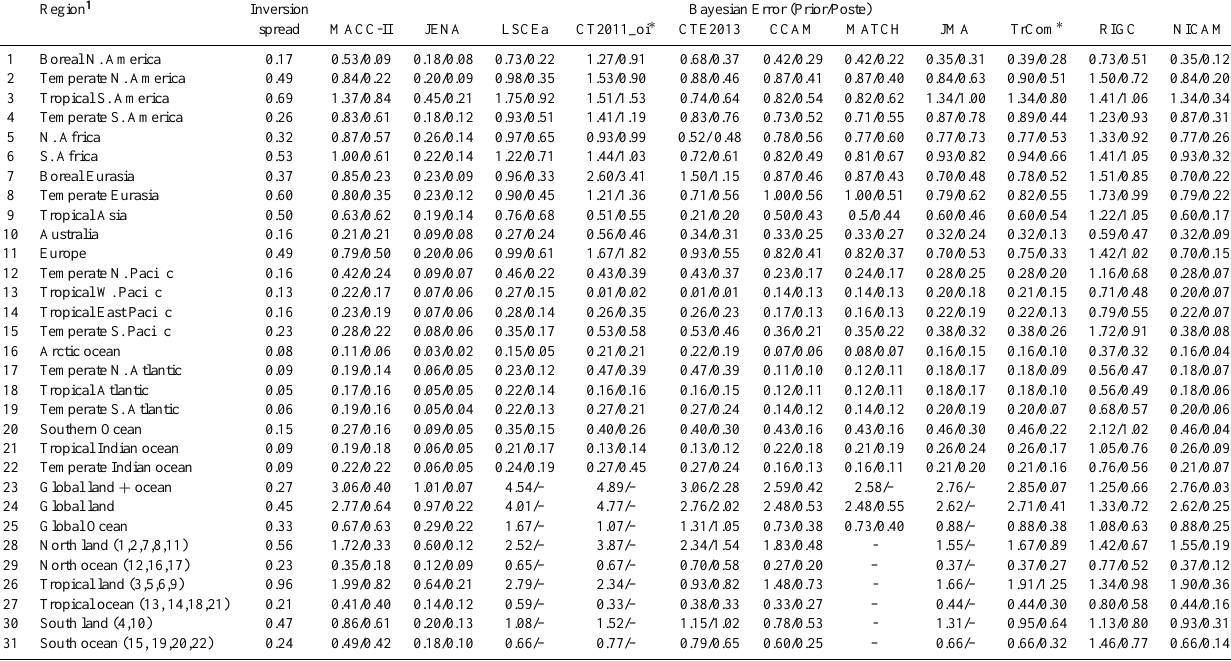
Table 2. Comparison of the annual mean flux uncertainty estimated from the spread of the inverse results (mean over the period 2001–2004 of the standard deviation of the annual flux) with the prior and posterior Bayesian uncertainty (one standard deviation) estimated for all inver- sions, for the 22 Transcom regions (see http://transcom.project.asu.edu/) plus 9 larger aggregates. Uncertainties are expressed in PgCyr − 1 . Note that some inversions were not able to provide the uncertainties for some regions (noted “–”) and that CT2011_oi as well as TrCom posterior uncertainty includes also an “external error” obtained from the spread of their ensemble of inversions (see